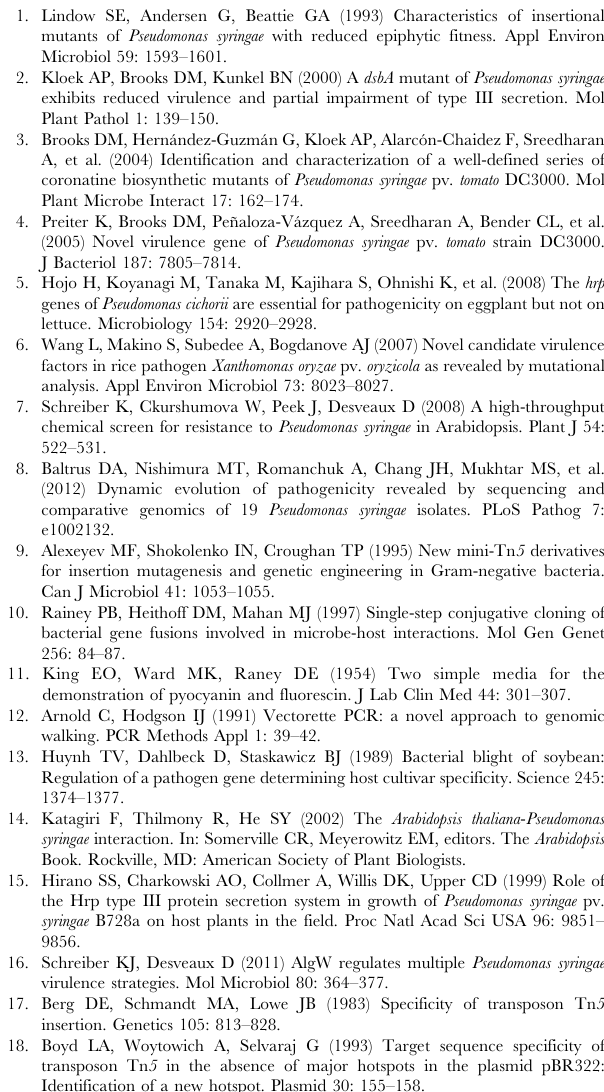
(upper) half of the leaf. Scale bar indicates 1 cm. Three independent experiments were performed with similar results. (TIF) Table S1 Primers used for gene expression analysis in Pma